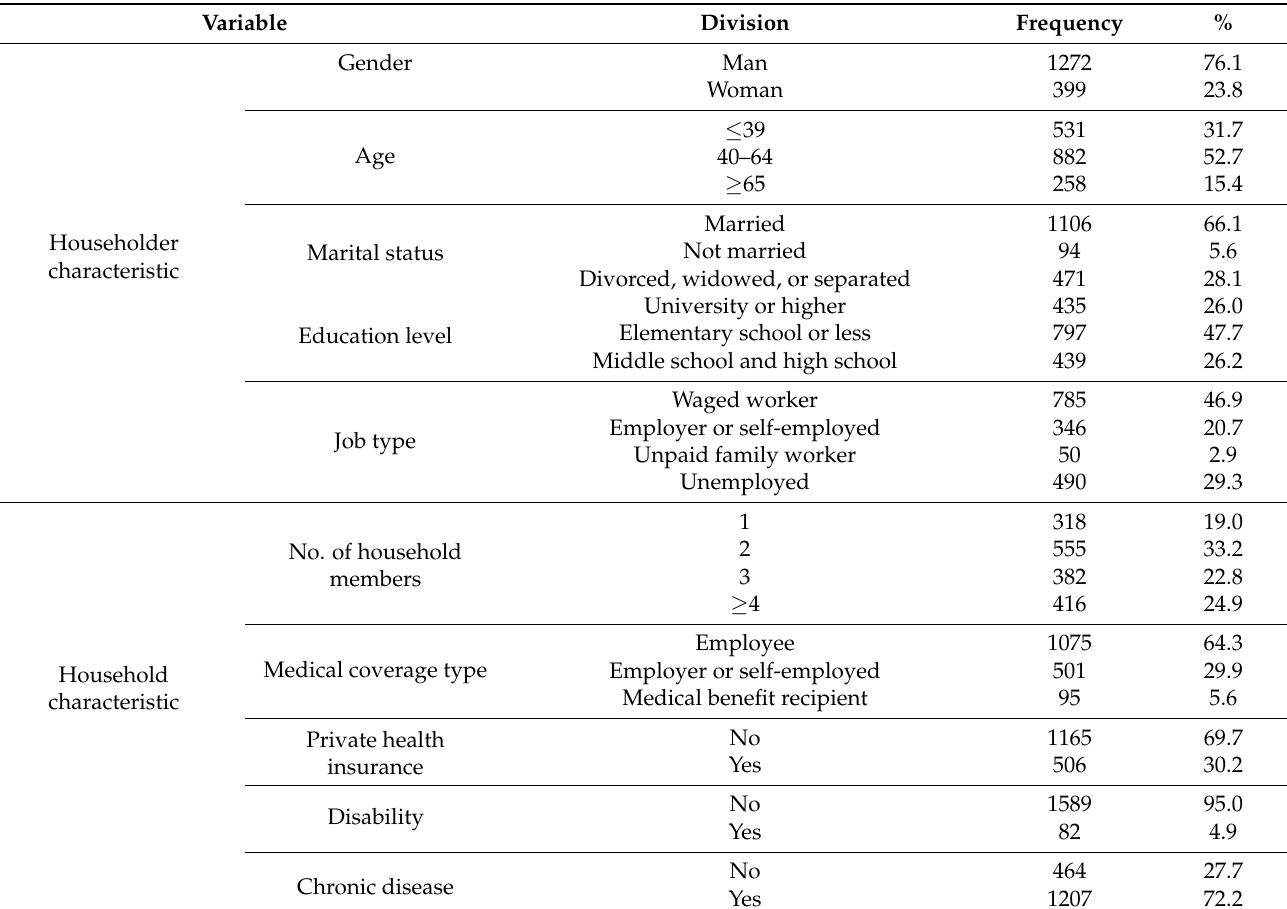
Table 1. Sociodemographic characteristics of the study subjects.